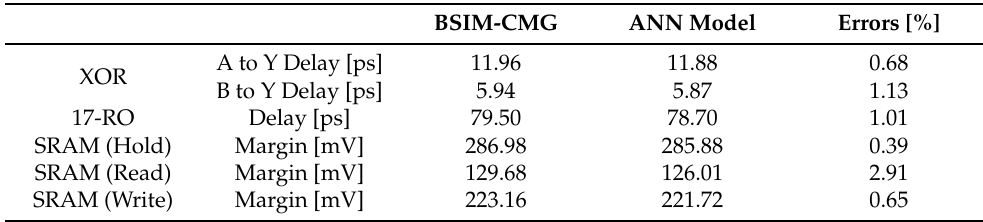
Figure 11. Comparison of the ANN and BSIM models’ results for the 6T-SRAM simulation: ( a ) hold operation margin, ( b ) read operation margin, and ( c ) write operation margin. Table 3. Circuit performance simulation results and errors between the ANN-based compact model and